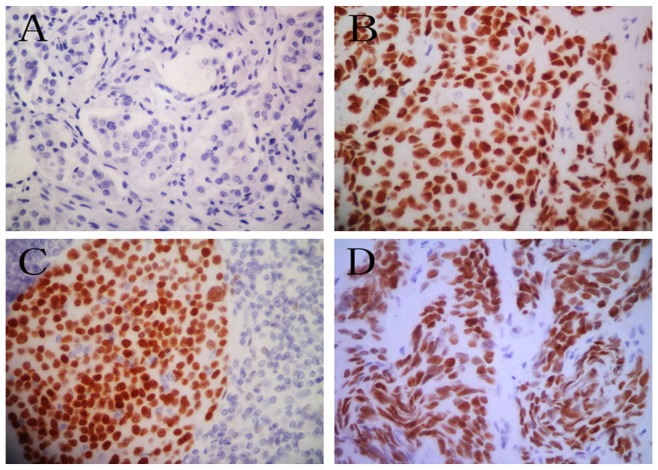
Immunohistochemical staining of the AR.A. negative staining; B. strong positive staining; C. immunoreactivity in axillary metastatic lymph node; and D. immunoreactivity in chest wall recurrence.